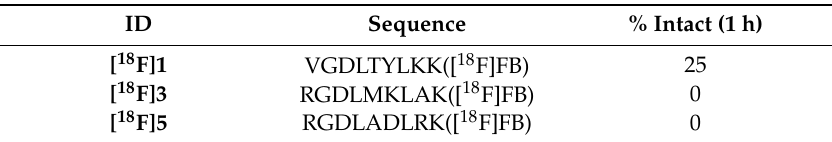
Table 4. Summary of the metabolic stability of 18 F ‐ radiolabeled lead peptides evaluated in mouse serum 1 h post ‐ incubation.